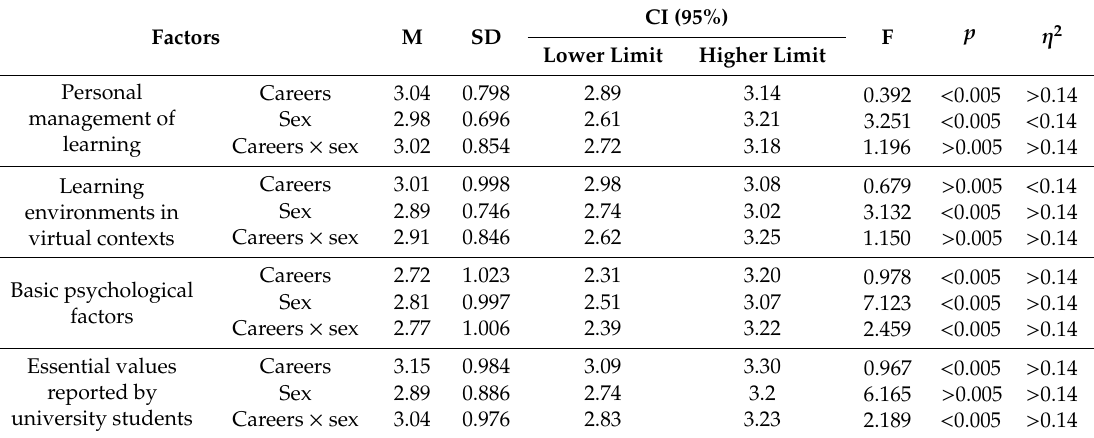
Table 1. ANOVA and e ff ect size ( η 2 ) sums of aggregated scales for Questionnaire of Psychological and Learning Environments in adaptive Contexts (QPLEC) by sex and field of